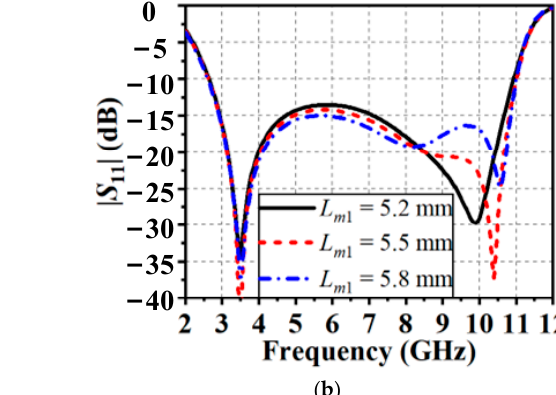
Figure 3. Simulated | S 11 | of the proposed absorber with different structure parameters: ( a ) L s and ( b ) L m 1 .